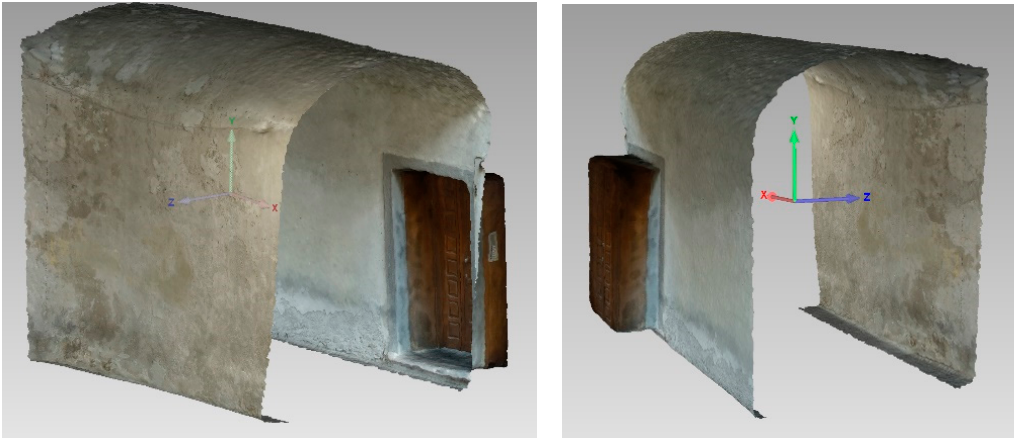
Figure 12. Some images of the textured 3D model of the alley generated from the equirectangular projections.